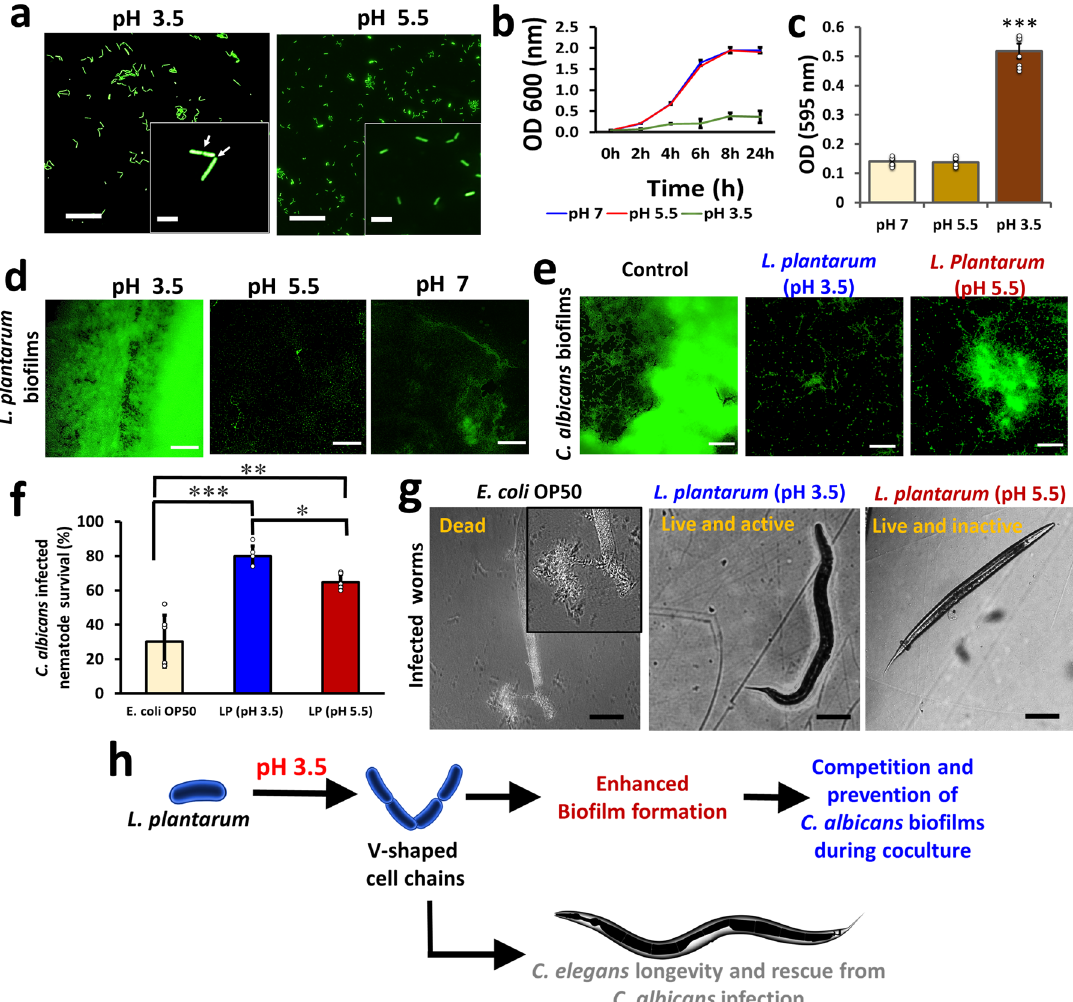
Fig. 5 Effect of acidic pH on the L. plantarum geometric structuring and subsequent bio fi lm formation accompanied with antagonistic activity against C. albicans . a Phenotypic appearance of L. plantarum 3297 cells grown at pH 3.5 or 5.5 in liquid MRS. Scale bar: 20 µm. White arrows indicate septation, inset scale bar: 2 µm. b Growth curves of L. plantarum grown at either pH 3.5 or 5.5. The cells were incubated at 37 °C for 24 h. c Crystal violet quanti fi cation of L. plantarum bio fi lms on polystyrene surface. The cells were incubated at 37 °C for 24 h without shaking, following which the cells were stained with 0.4% crystal violet and detected at OD 595 . The graph shows the means ± SEMs of 9 individual data points, obtained from three independent measurements. *** P < 0.001 vs. the non-treated controls. Here cells grown at pH 5.5 are taken as a control. d Fluorescent microscopic images of L. plantarum bio fi lms on polystyrene surface stained with SYTO ™ 9. Scale bar: 200 µm. e Effect of live probiotic cells ( L. plantarum cells grown at either pH 3.5 or 5.5) on mature C. albicans bio fi lms in in vitro conditions. C. albicans bio fi lms were grown on polystyrene plates. After 8 h of incubation, the broth containing the planktonic cells were removed, replaced with PBS (controls) or live L. plantarum in PBS, and incubated again for 24 h. Bio fi lm formation was then assessed microscopically after staining with SYTO ™ 9. Scale bar: 200 µm. f Survival rates of nematodes (that was prior fed with L. plantarum cells grown at either pH 3.5 or 5.5 or E. coli OP50) infected with C. albicans . The graph shows the means ± SEMs of 9 individual data points, obtained from three